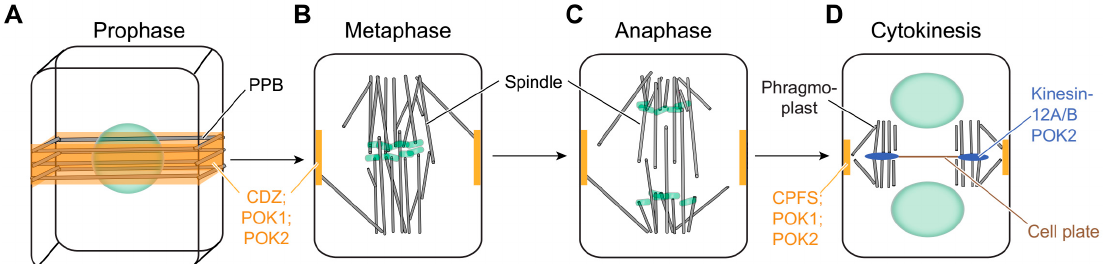
Figure 2. Depiction of localization patterns of characterized Arabidopsis kinesin-12 throughout mitosis and cytokinesis. ( A ) POK1/Kin12C and POK2/Kin12D (orange) colocalize with microtubules (grey)